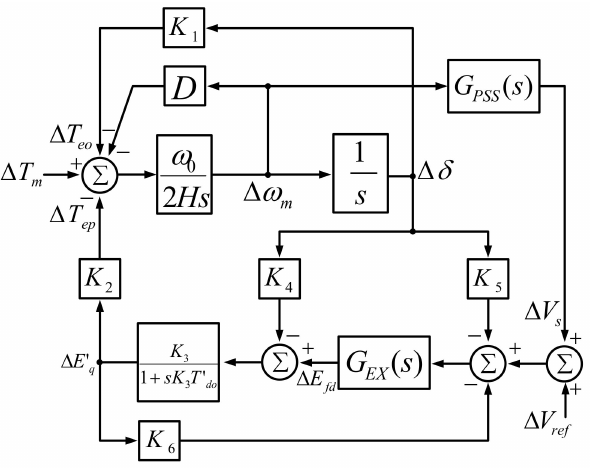
Figure 1. Single-machine infinite bus (SMIB)